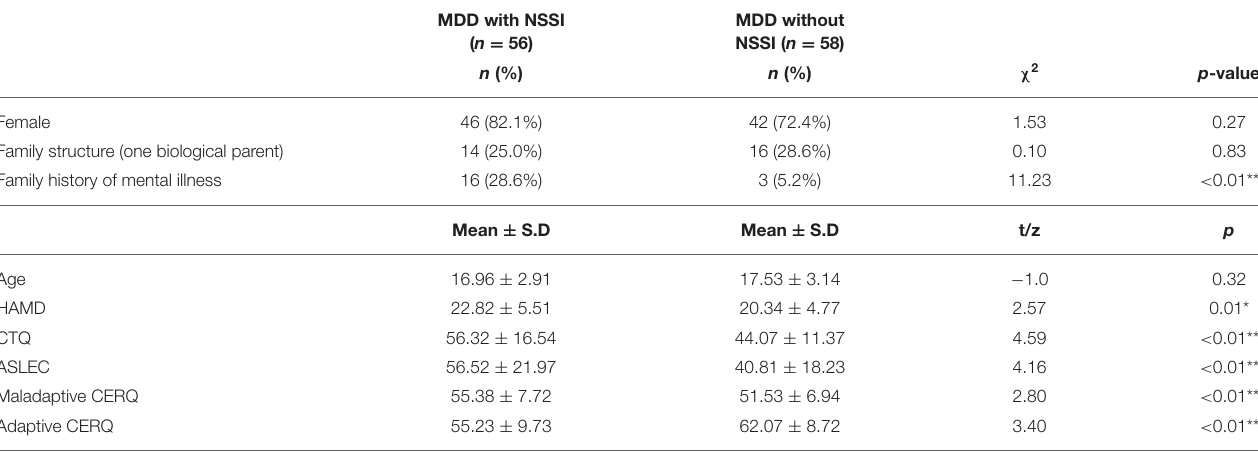
TABLE 2 | Differences between MDD patients with and without NSSI.